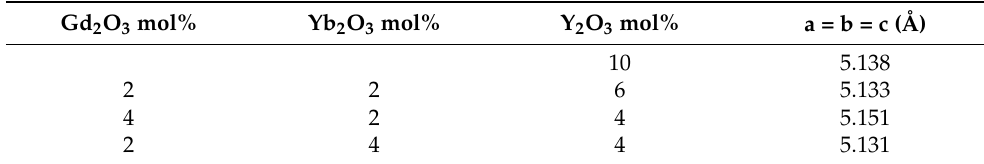
Table 1. Lattice parameters in different ceramic